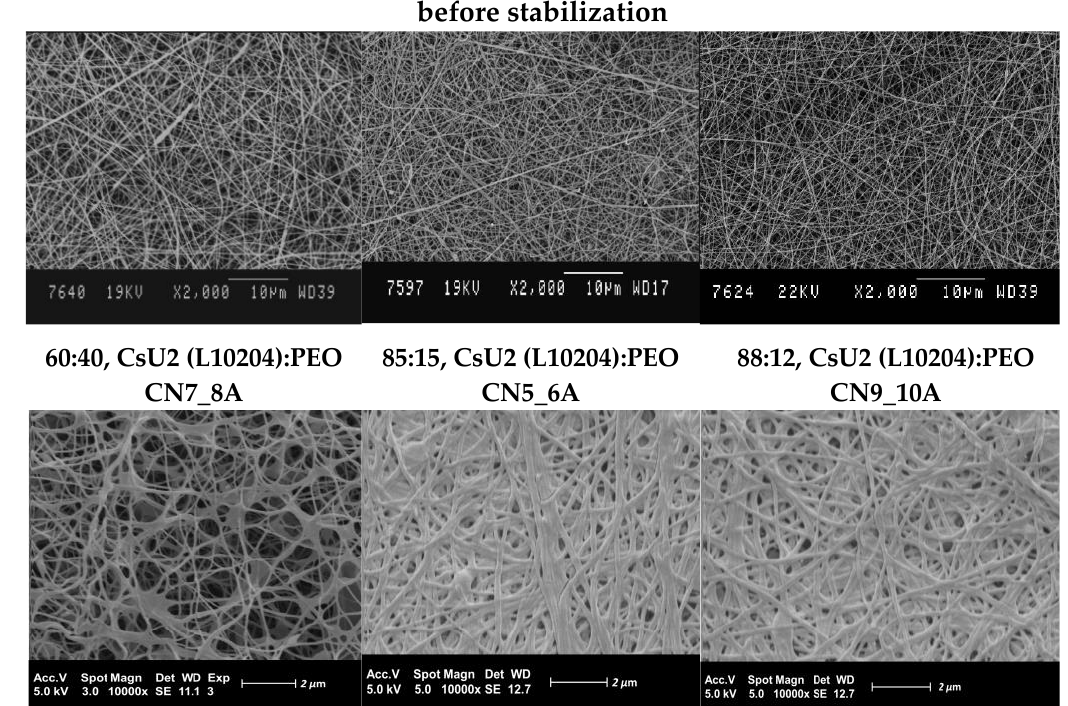
Figure 7. ESEM analysis of CsU2 (L10204) based mats.